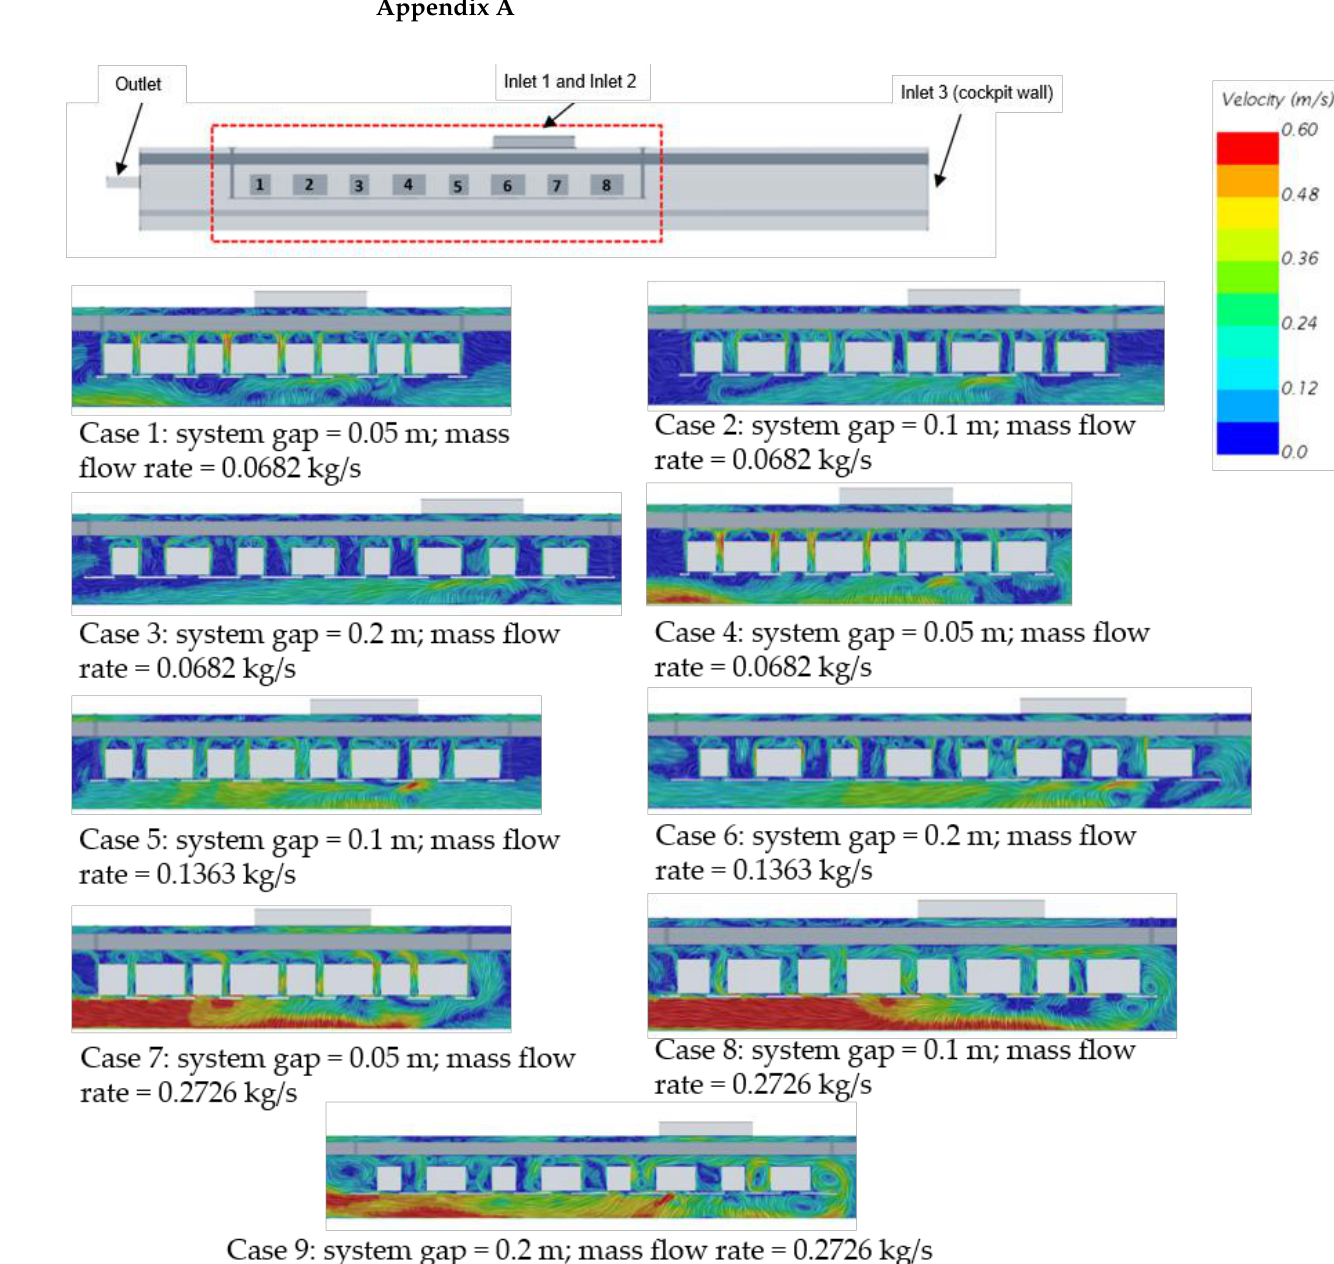
Figure A1. Velocity magnitude contour for all studied cases of Configuration 2.